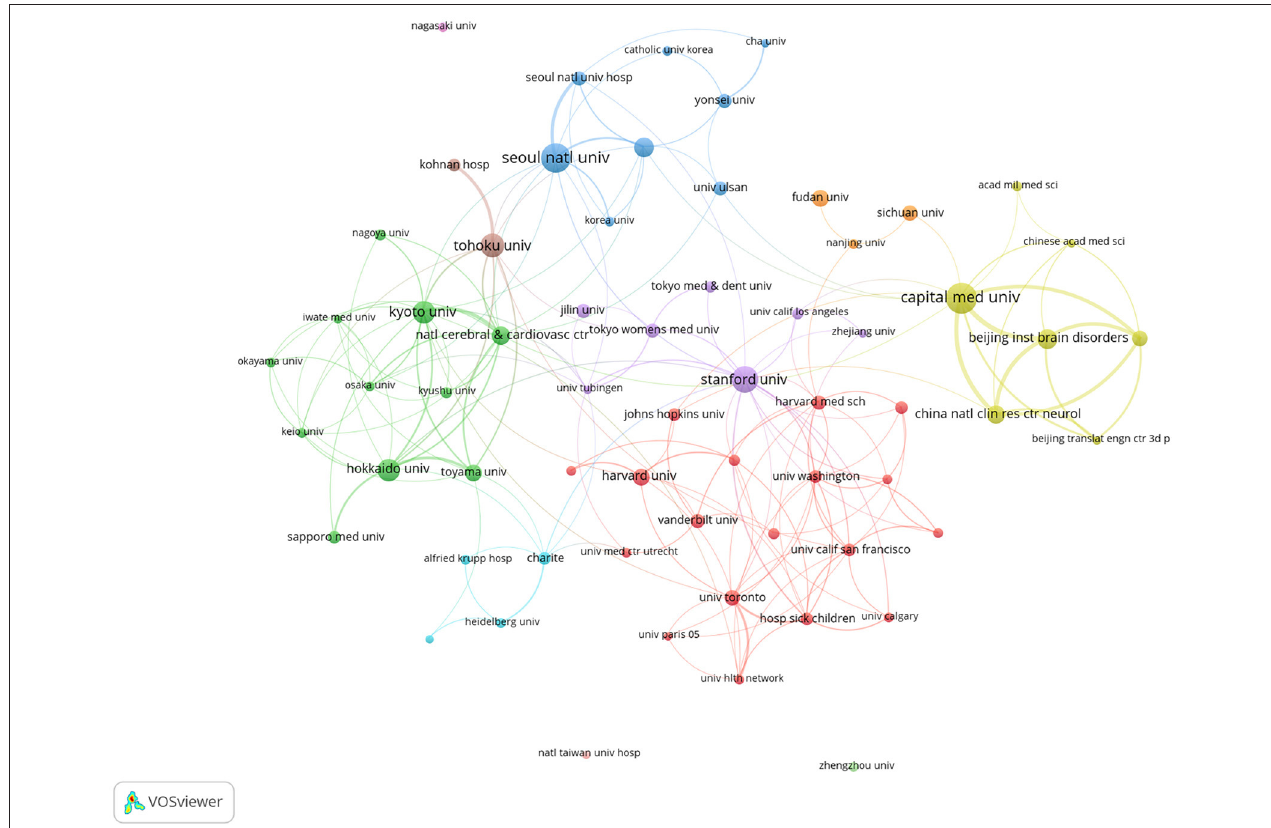
FIGURE 4 | The co-authorship network visualization map of institutions for MMA research.